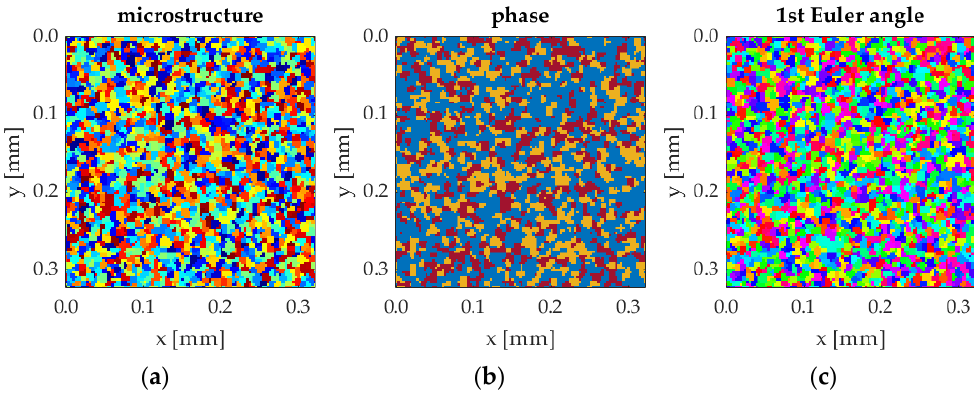
Figure 2. A 2D cross-section of: ( a ) a microstructure; ( b ) the corresponding three phases; and ( c ) the first of three Bunge Euler angles. The colors in ( a ) refer to a grain number, the colors in ( b ) refer to the phase, and the color scale in ( c ) is related to an angle between 0 and 2 π